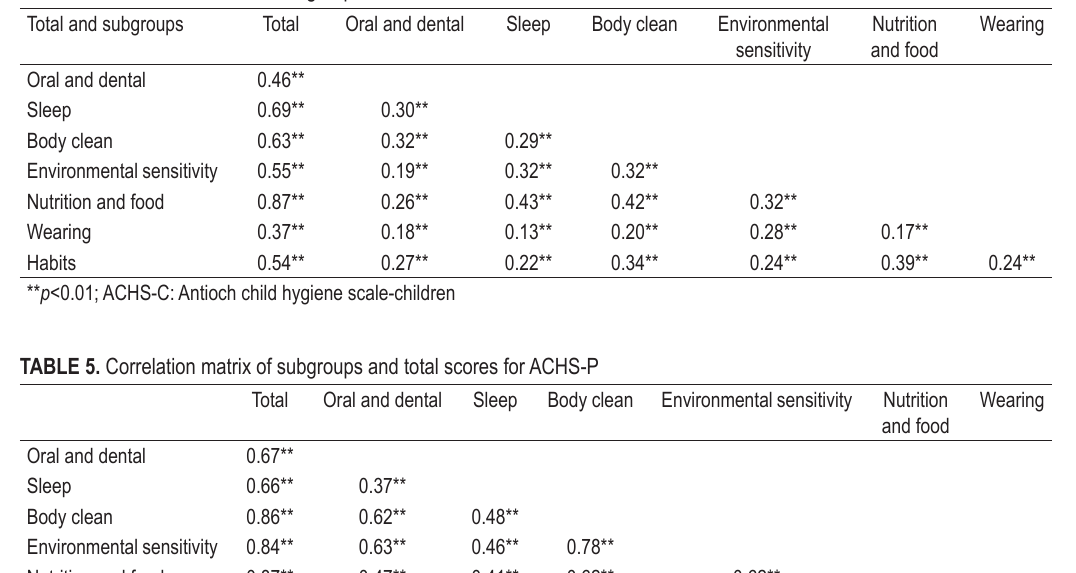
Environmental sensitivity Nutrition and food